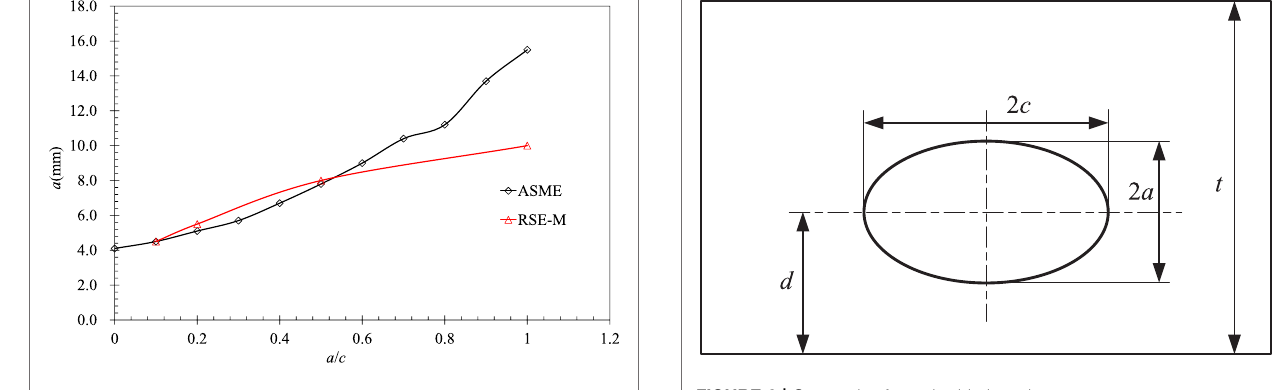
FIGURE1| AllowableembeddedcracksizesinRPVgivenbyASMEand RSE-M.